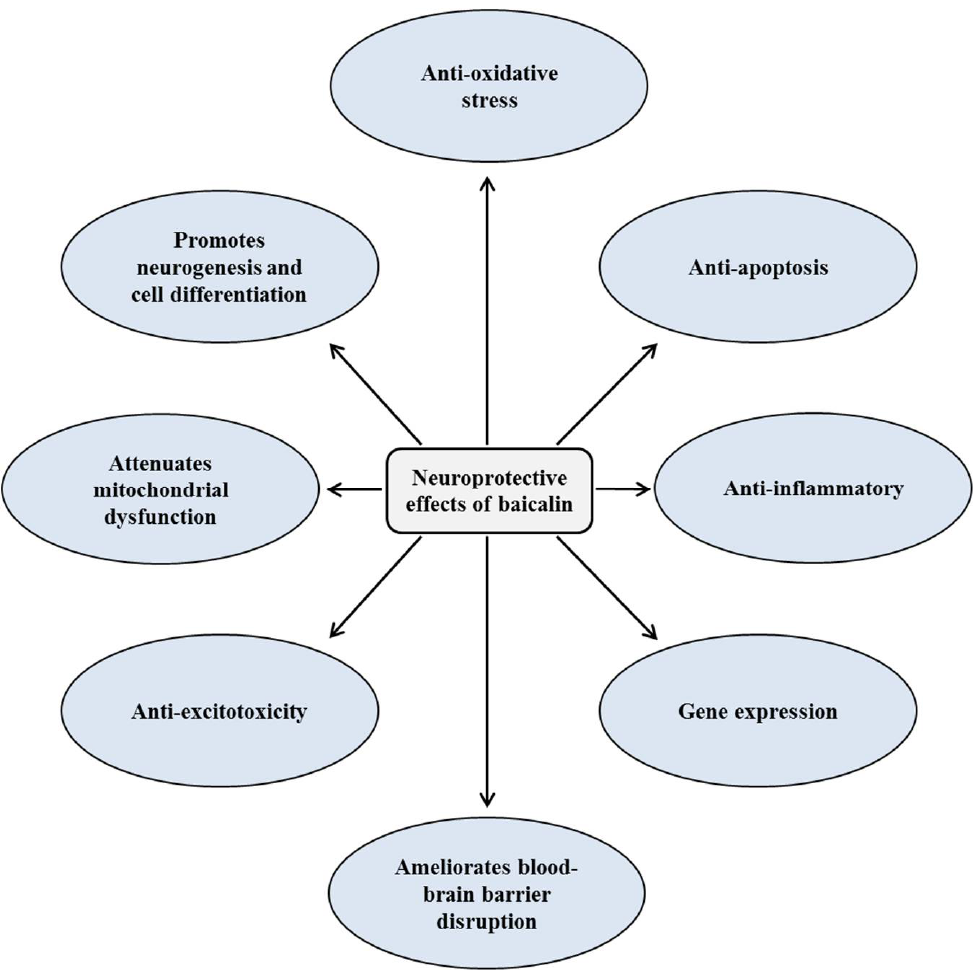
Figure 2. Mechanisms of neuroprotective and cognitive enhancement effects of baicalin.